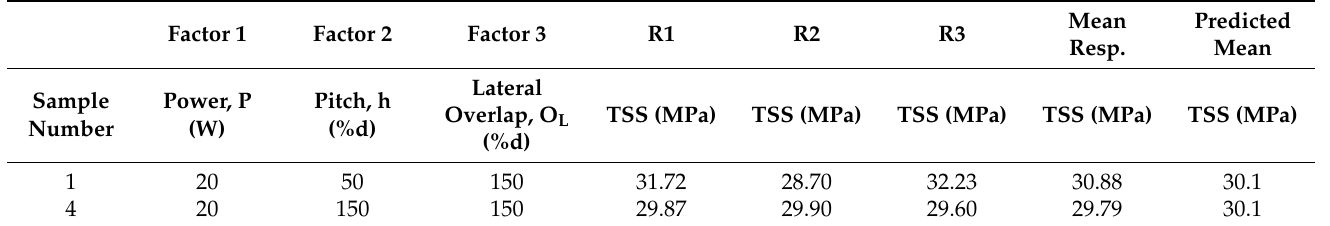
Table 11. Experimental vs. predicted mean of samples treated with P = 20 W, O L = 150%, and variable h.